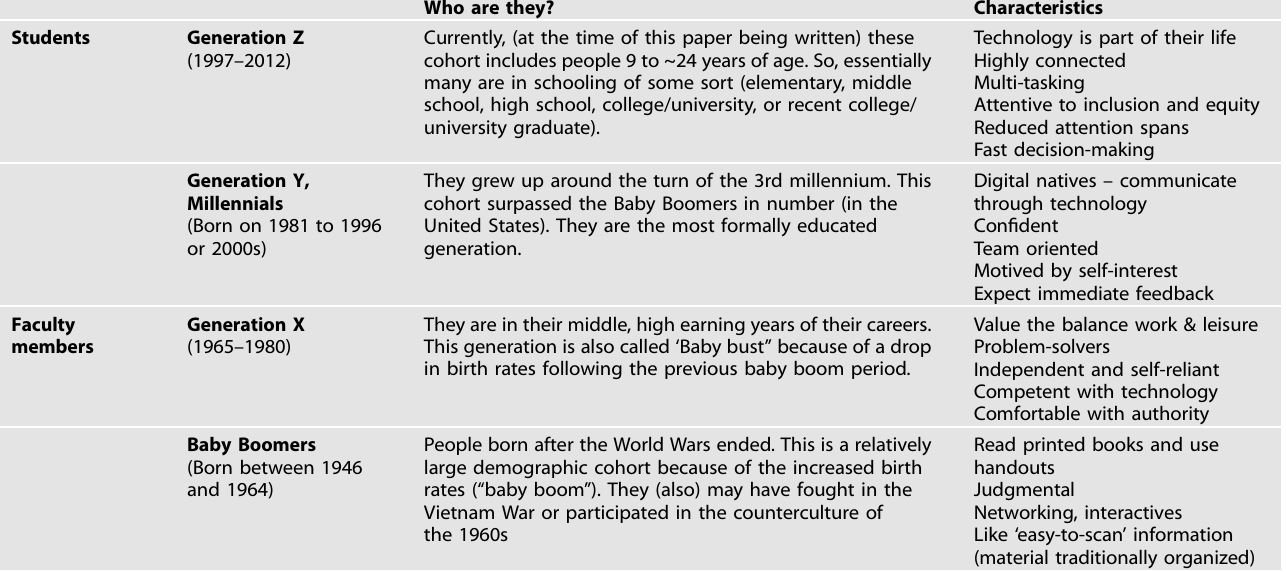
The table concepts based on the ‘ Western world/US generations ’ [Strauss – Howe generational theory [3, 46]*, (Statistics Canada [https://www12.statcan.gc.ca/ census-recensement/2011/as-sa/98 – 311-x/98 – 311-x2011003_2-eng.cfm]), and some characteristics/styles of each generation-learner [21, 45]*. *Speci fi c initial and end dates are variable depending on the